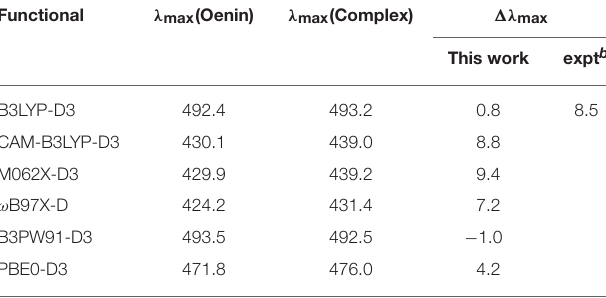
TABLE 8 | Vertical excitation energies E max , maximum absorption wavelengths